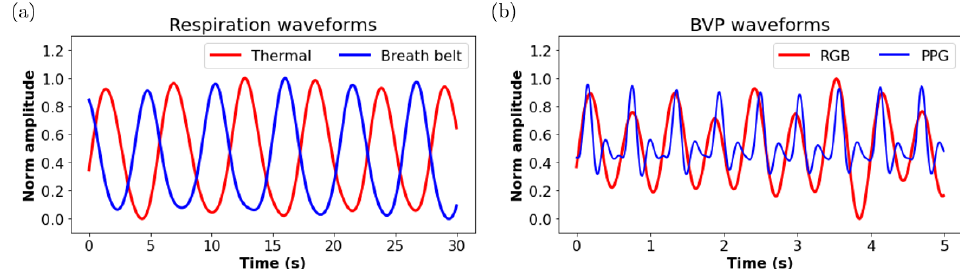
Figure 10. ( a ) Respiration waveform extracted from the thermal camera (red) and the reference measurement using a breath belt (blue), ( b ) BVP waveform extracted the RGB camera (red) and reference PPG waveform (blue).